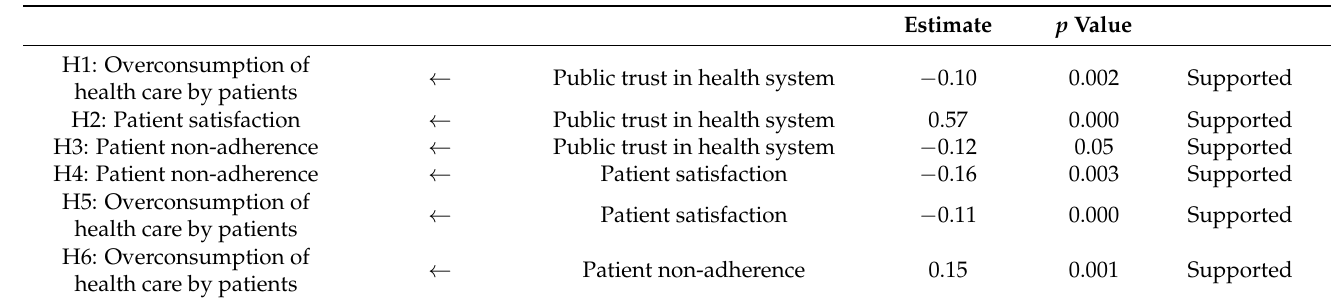
Table 6. Standardized regression weights.